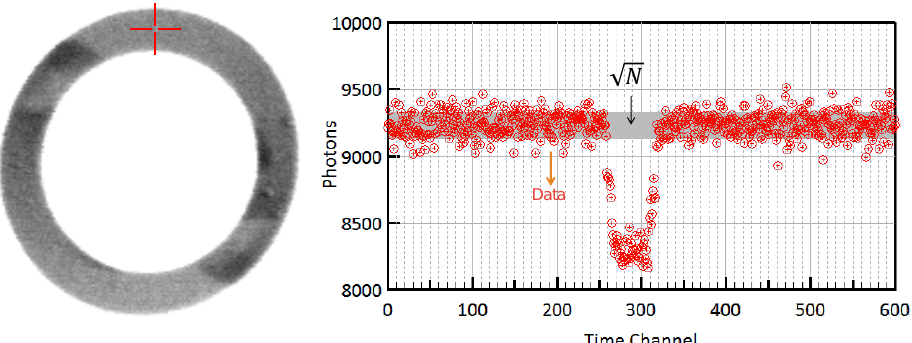
Figure 3. Example image of a pump-and-probe measurement showing the advantages of the syn- chronization scheme used, see also Ref. [37]. A snapshot of rotating domains in a Ni 81 Fe 19 ring (top right) highlighting that, despite using the full filling pattern of the synchrotron with gap and cam- shaft pulses, the dynamic imaging is shot-noise limited in fidelity: In the right graph, the raw ab- sorption data is plotted for a single point (indicated by the red cross), thereby not only directly showing the passing of a domain wall, but also having a noise figure that compares well with the gray bar, indicating a noise level of ( N ) 1/2 .